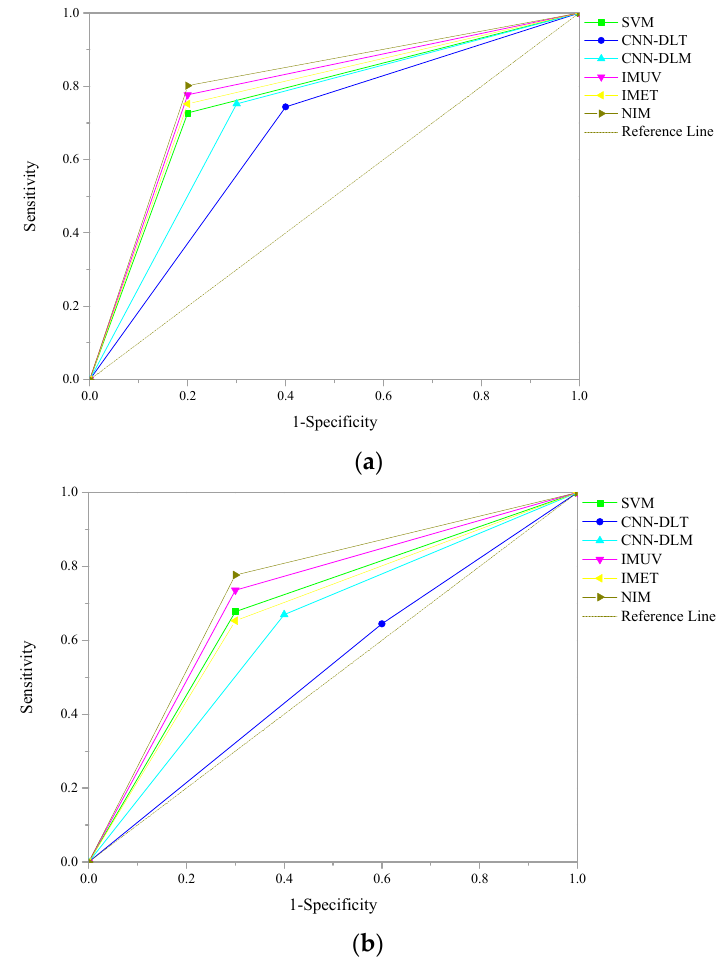
Figure 5. The ROC curve of each model with the comprehensive training data and the testing data. ( a ) Evaluation results with the testing data set of the year ( t − 2 ) ; ( b ) evaluation results with the testing data set of the year ( t − 3 ) . The confidence level is 95%.